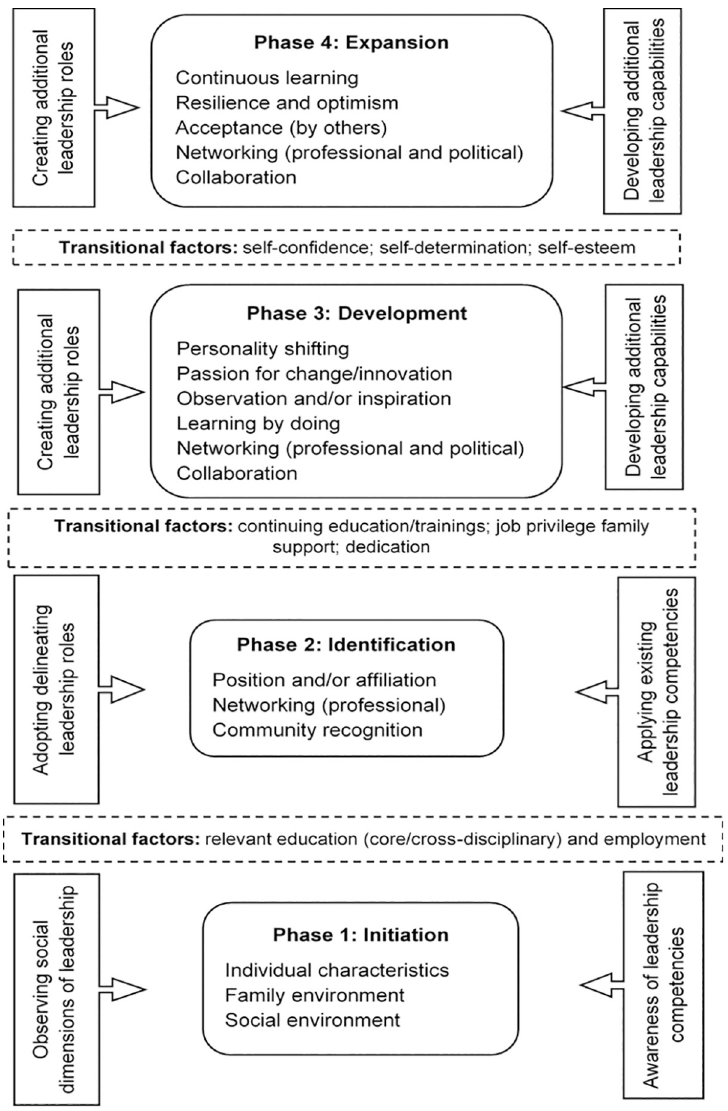
Fig 1. Theory on public health leadership development in Nepalese context.